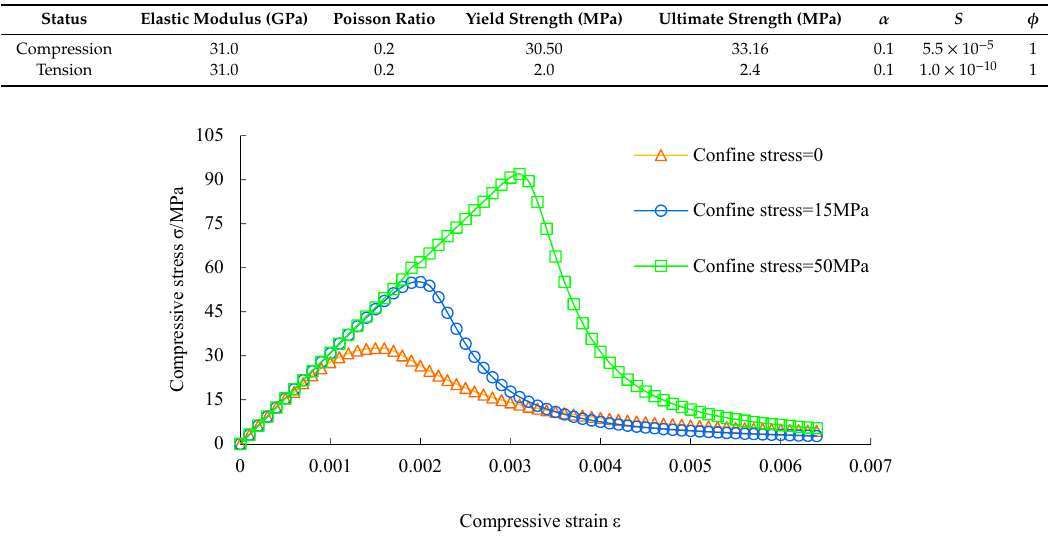
Figure 3. Damage factor of concrete under compression. Figure 4. Stress-strain curve of concrete under tension. 2.2. Constitutive Response of the Interface in Mixed Mode The Cohesive Zone Model (CZM) [18] was used to simulate the concrete/FRP and concrete/steel interface. The CZM constitutive model consists of three displacement jumps (interfacial separation) Δ i , corresponding to three engineering stresses σ i , where Δ 1 and Δ 2 are displacement jumps in the shear direction, and the equivalent shear displacement jump is